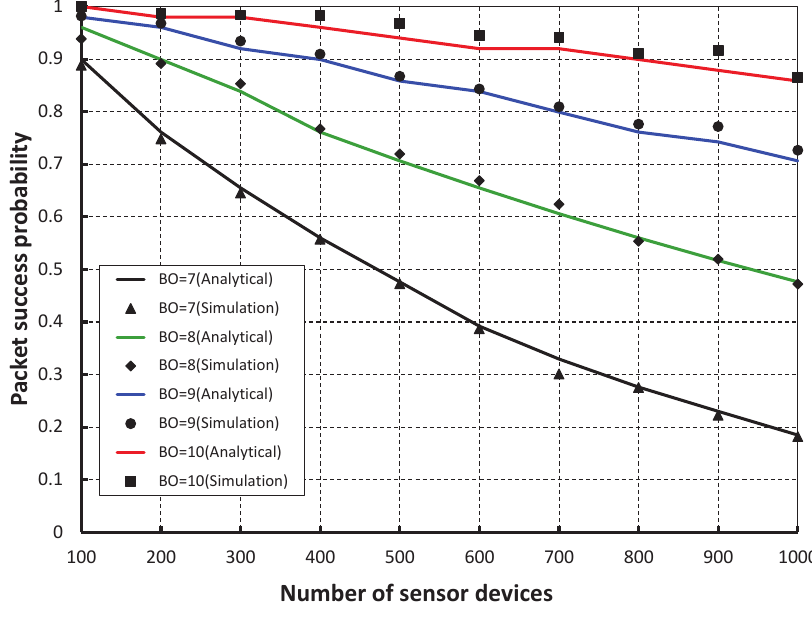
Figure 6. Validation of packet success probability for different beacon